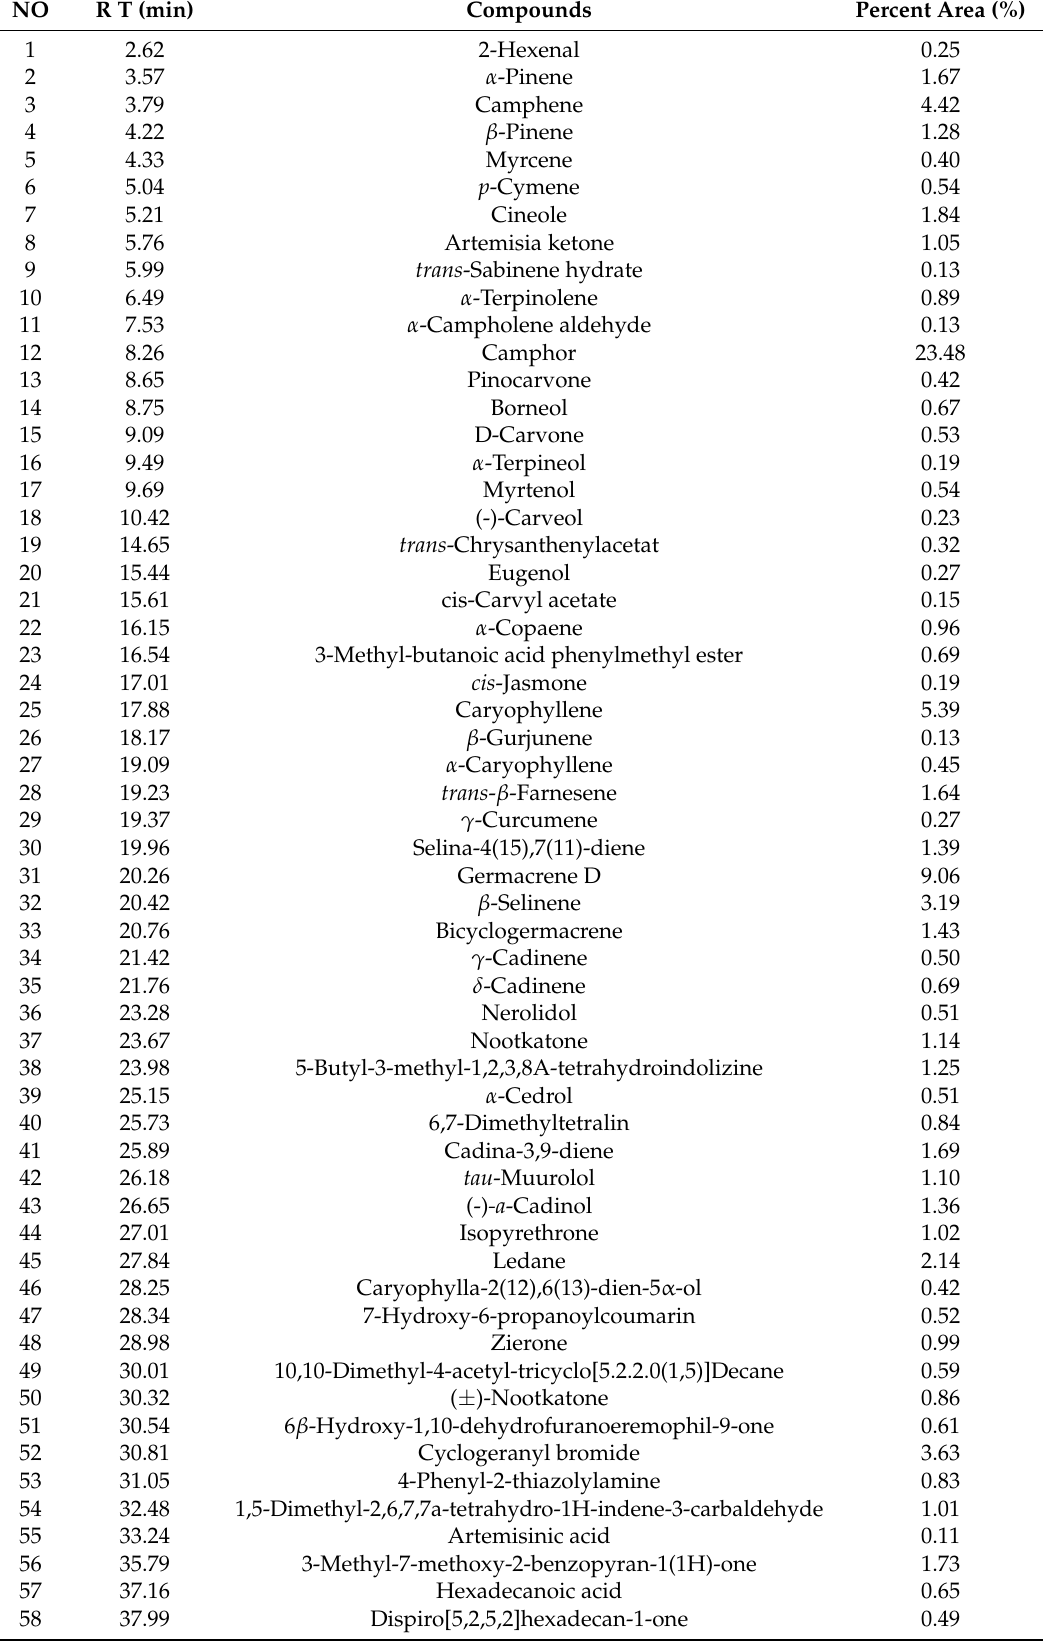
Table 1. Chemical composition and content of EO from A.